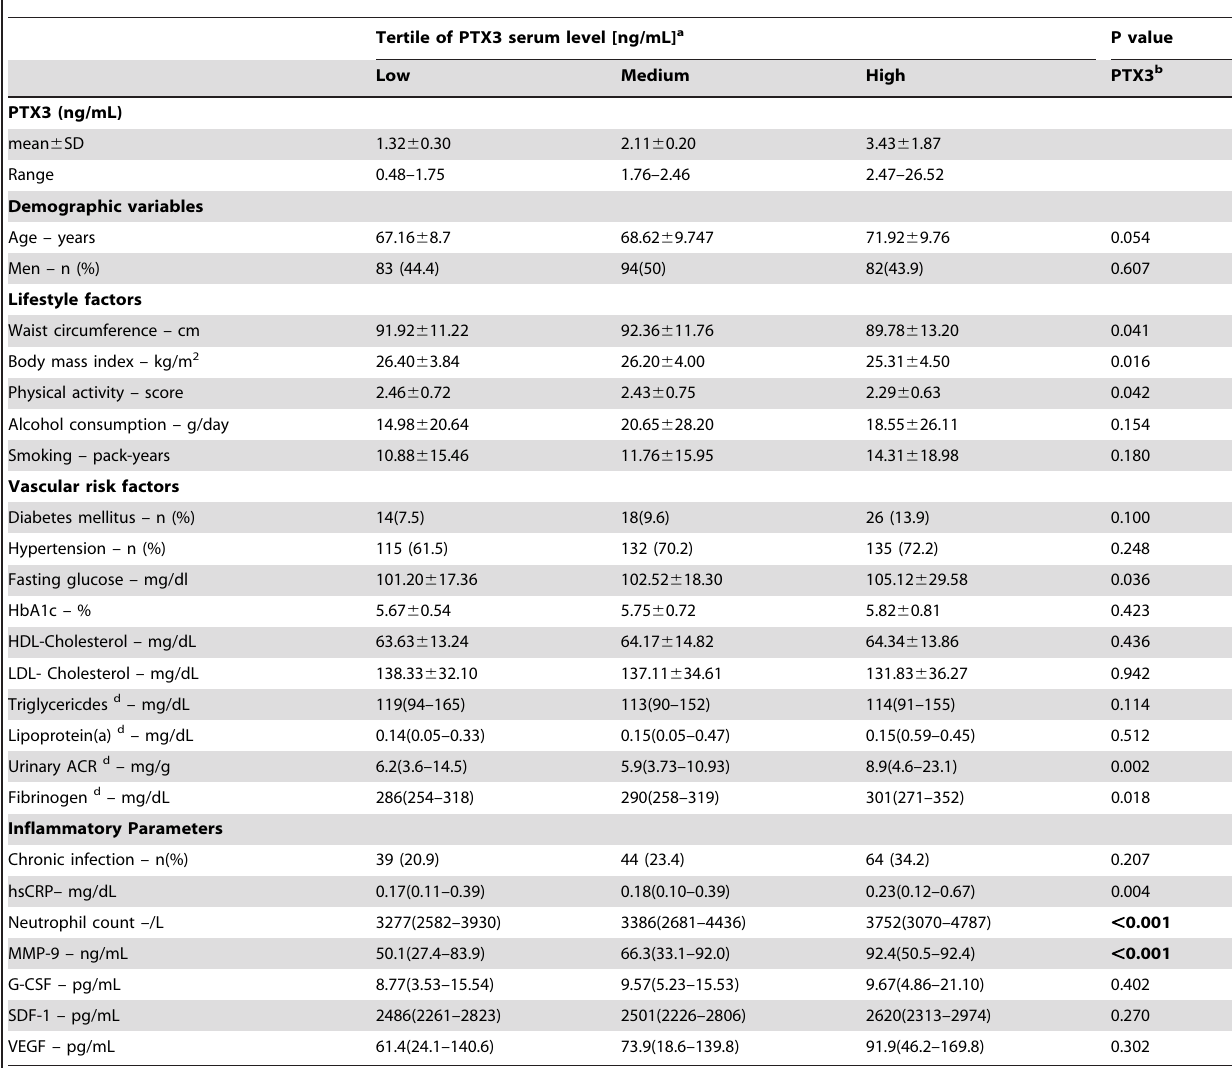
Table 1. Population characteristics according to PTX3 tertile groups in the Bruneck